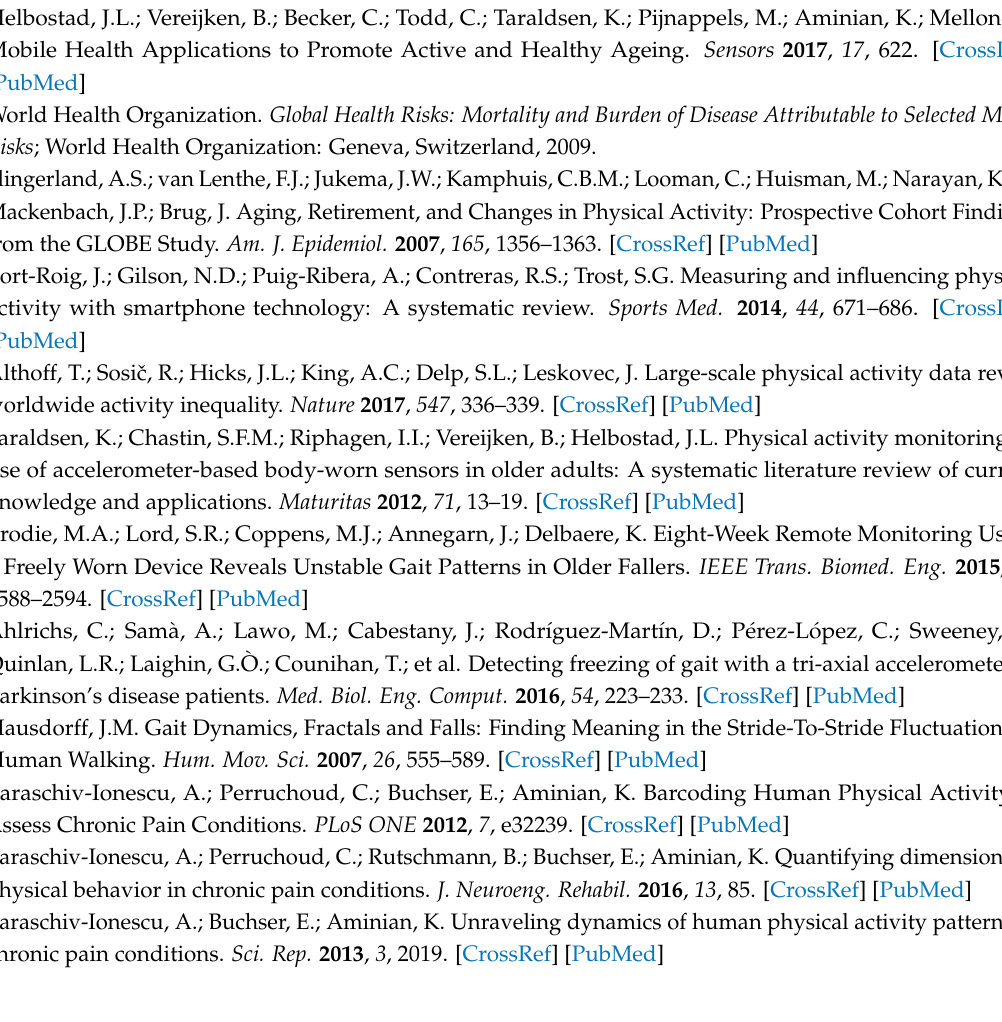
Figure A2. CV before and after smoothing PA time series.